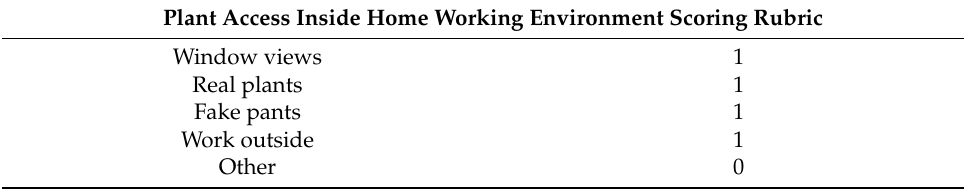
Table A6. Plant access assessment for survey answers. Participants were told to select all that applied, and scores were cumulative based on their selections.